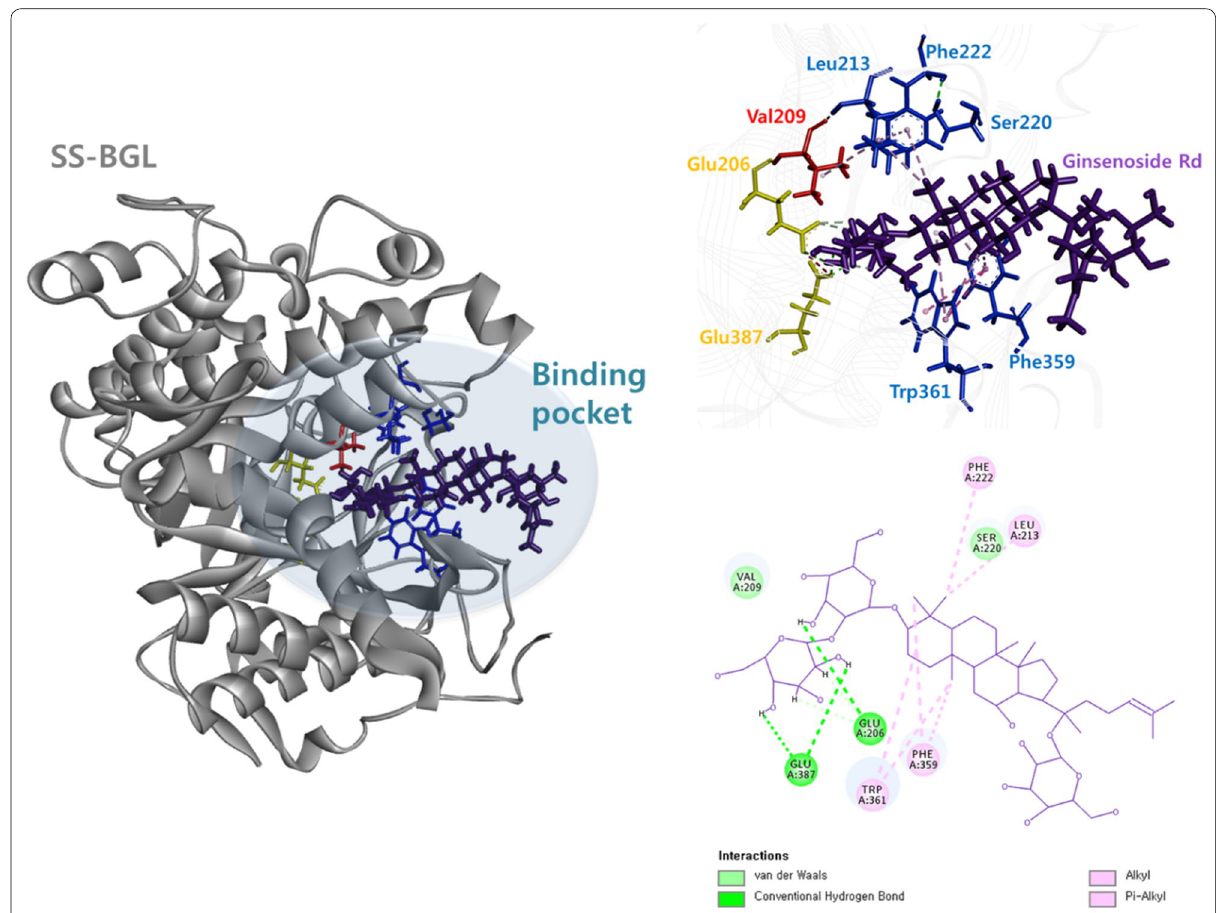
Fig. 3 Docking pose for selection of candidate residues related to ginsenoside Rd‑hydrolyzing activity. 3D‑ and 2D‑structures represent receptor‑ ligand and receptor–receptor interaction, and only receptor‑ligand interaction, respectively. SS‑BGL (PDB entry, 1GOW), grey ginsenoside Rd, purple catalytic residues, yellow residues related to Rd‑hydrolyzing activity, red candidate residues related to Rd‑hydrolyzing activity, blue hydrophobic inter‑ actions, pink dotted line and hydrogen bonds, green dotted